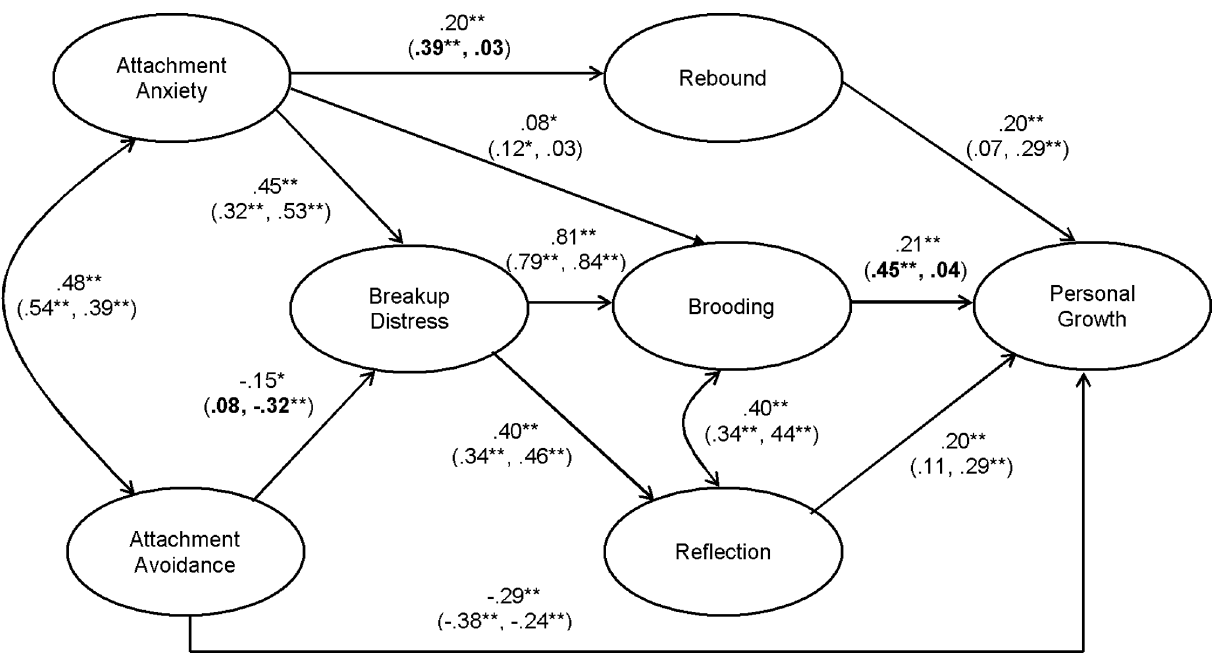
Figure 2. Study 2: Final model. The values within parentheses are the path coefficients for people whose breakup occurred longer ago (left side) and more recently (right side). Bolded values represent a significant group difference in the path coefficients. { p , .10,*p , .05, **p , .01.